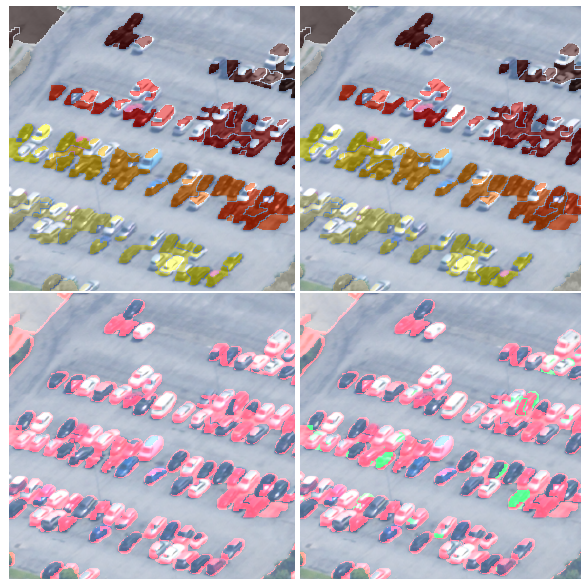
Figure 4. Top: Hitmap for the ucm alone thresholded at the highest segmentation covering (left) and hitmap with the presented algorithm (right). Bottom: The failed pixels marked in red. In the fused segmentation, the fails from the RGB segmentation not present in the fused one are marked in